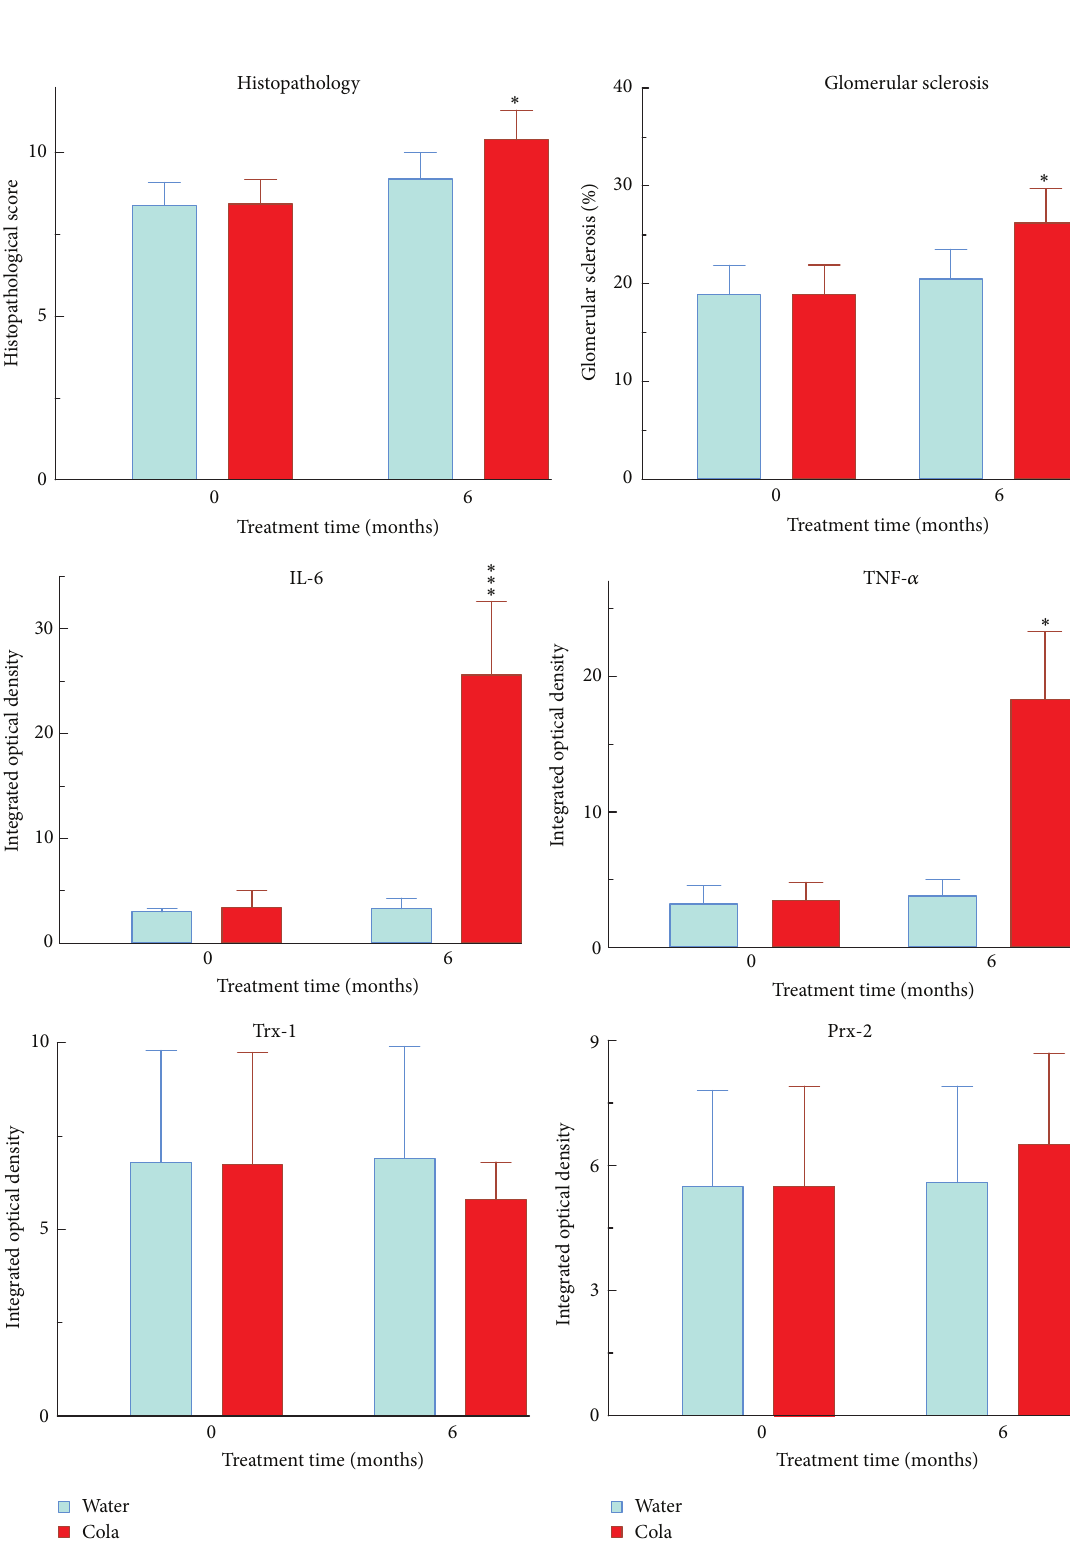
Figure 6: Renal glomerular pathology, inflammatory cytokines, and redoxins in renal tubules before and after cola treatment. IL-6: interleukin-6, TNF- 𝛼 : tumor necrosis factor-alpha, Trx-1: thioredoxin-1, and Prx-2: peroxiredoxin-2. ∗ 𝑝 < 0.05 and ∗∗∗ 𝑝 < 0.001 compared with